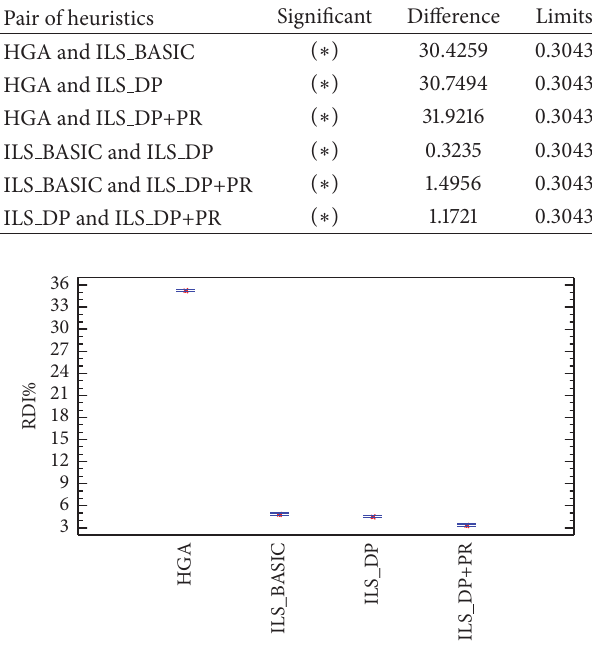
Figure 5: Means plot and Tukey’s HSD intervals at 95% confidence level for all heuristics and all large instances.